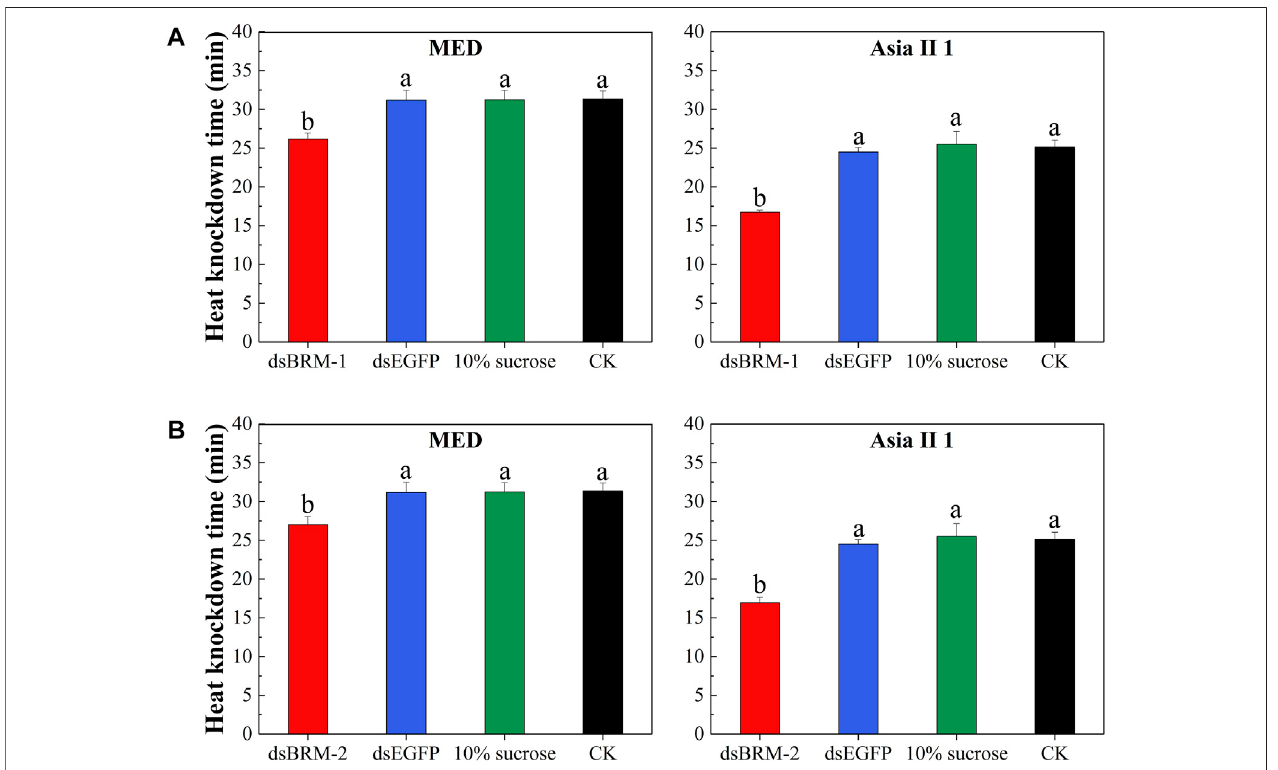
FIGURE 8 | Mean heat knockdown time (TKD) after double-stranded RNA (dsRNA) feeding in white fl y adults. Compared with the control groups (white fl ies untreated (CK) or fed dsEGFP or 10% sucrose), TKD for MED and Asia II 1 after feeding with Bt-BRM-1 (A) or Bt-BRM-2 (B) dsRNA was signi fi cantly decreased. Moreover, heat resistance of the two cryptic species was reduced differently after interfering with the remodelers (details are listed in Supplementary Table S3 ). The data are presented as the mean ± SE; n = 200. Bars with different lowercase letters are signi fi cantly different at p < 0.05.